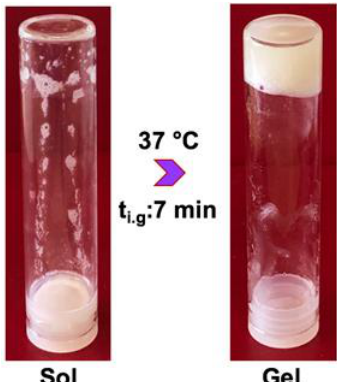
Figure 2. A representative sol–gel transition image of a composite SI hydrogel solution (2 mL) in a closed glass test tube (75 mm × 18 mm) placed into a silicone oil bath at 37 °C. t i.g . : incipient gelation point was determined with the test tube invert method as 7 min.